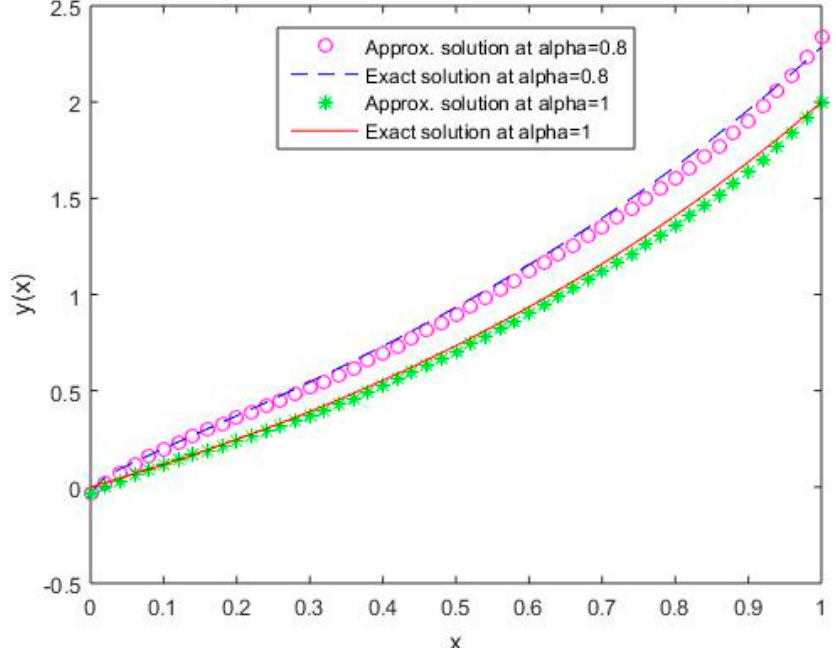
Figure 14. Comparison of exact and numerical solutions using S4 for 𝛼 = 0.8 and 𝛼 = 1 , Example 2.